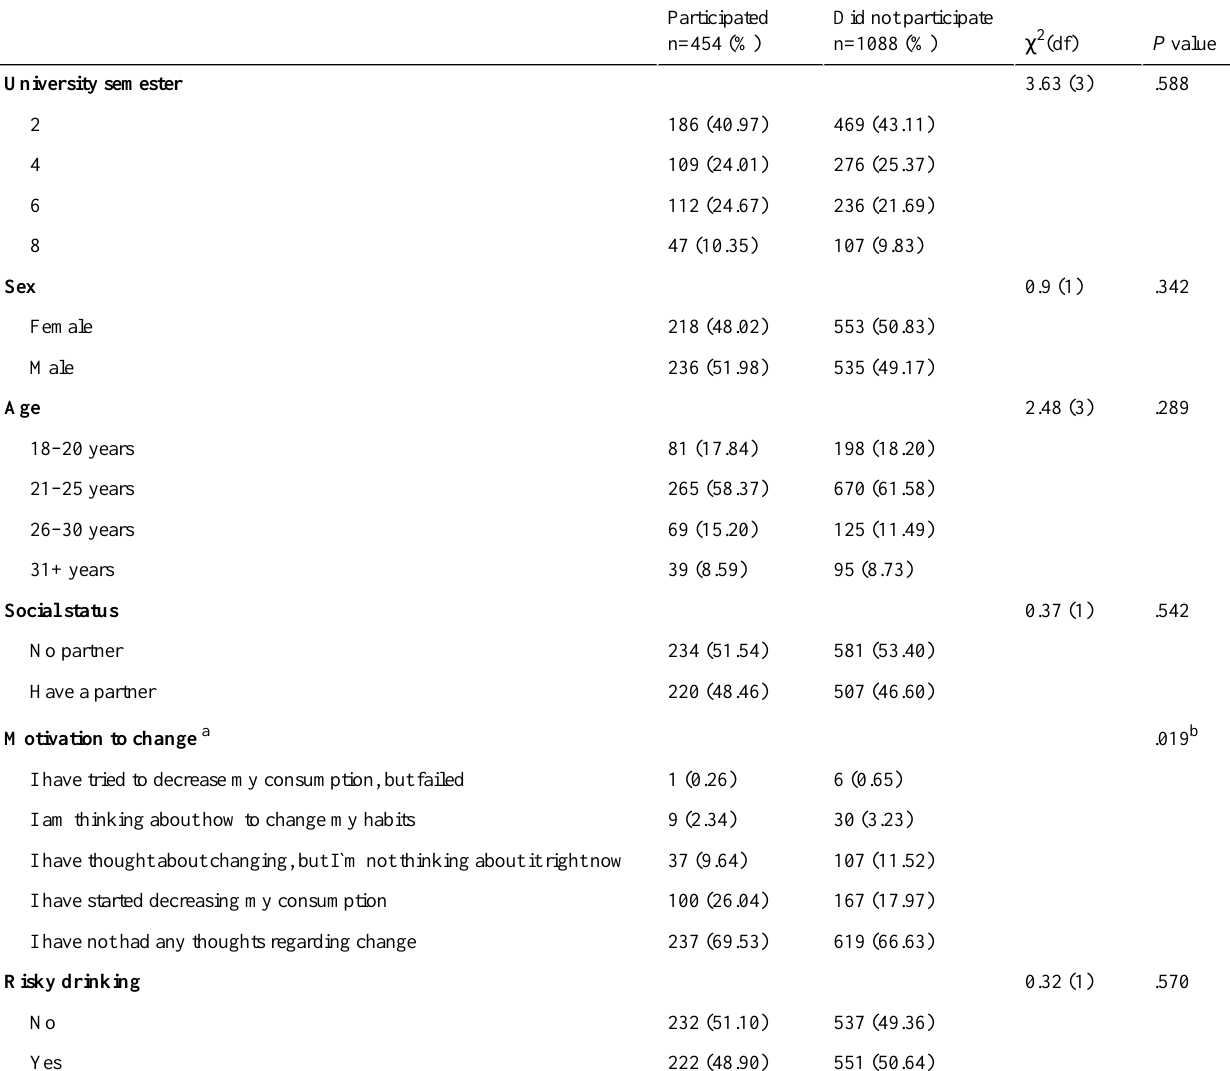
Table 1. Baseline characteristics of the participants who agreed to participate or declined participation in the extended intervention ( N